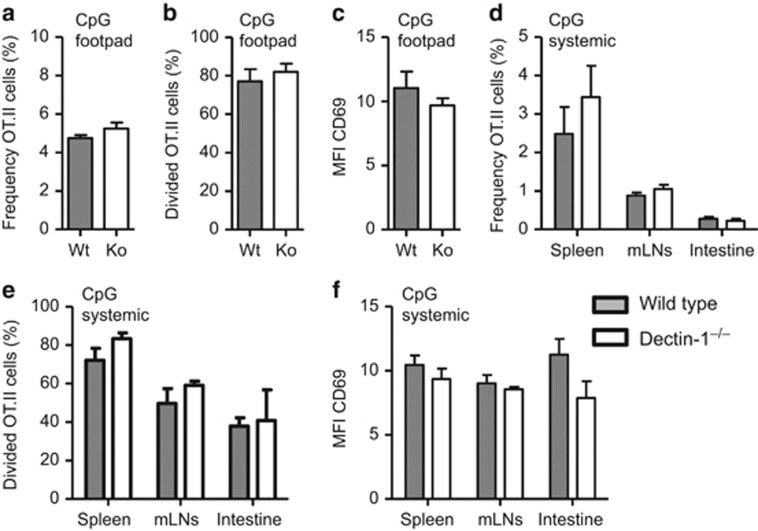
Loss of Dectin-1 does not confer global CD4+ T-cell defects. In total, 3 × 106 OT.II T-cells were adoptively transferred into WT (filled bars/circles; n=5) and Dectin-1 KO (clear bars/circles; n=5) mice that were subsequently immunised with 3 μg ovalbumin and 2 μg CpG in the foot pad. Draining popliteal LNs were isolated at 4 days post immunization and OT.II cell (a) frequency, (b) division, and (c) activation analyzed as in Figure 1. (d–f) WT (n=4) and Dectin-1 KO (n=4) mice were immunised with 20 μg ovalbumin and 20 μg CpG systemically via the tail vein, and OT.II responses analyzed at 4 days post immunization as above. Data are from one experiment. CpG, oligodeoxynucleotide.